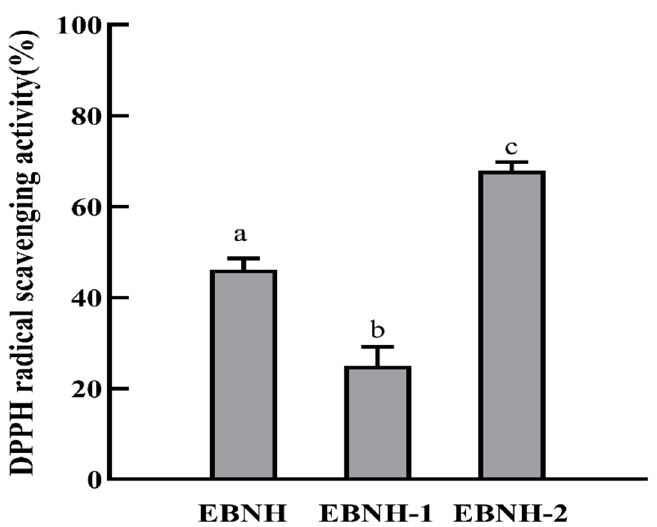
Figure 4. DPPH radical scavenging activities of EBNH, and its ultrafiltration fractions EBNH-1 and EBNH-2 at a concentration of 2 mg/mL. The data indicated as means ± SD (n = 3). The column values of a–c with the same superscript indicated an insignificant difference ( p > 0.05).